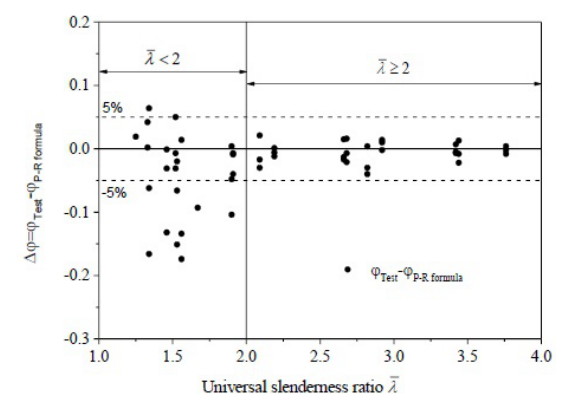
Figure 11: Error distribution of theoretical and experimental stability factors of CFRP tubes